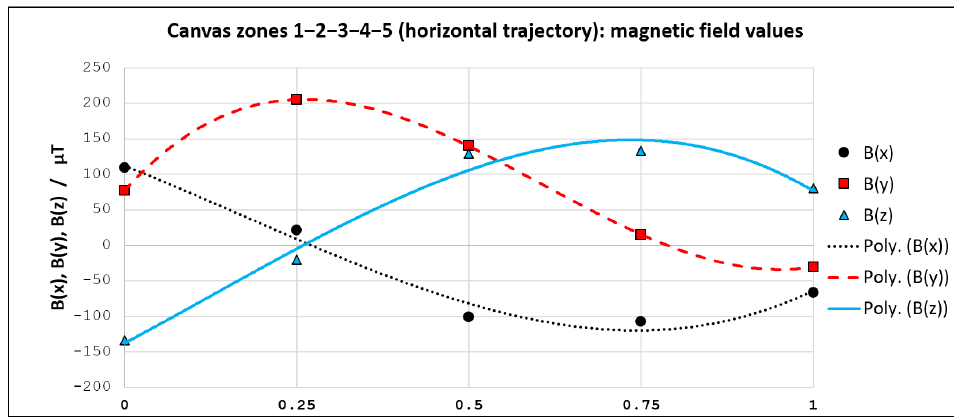
Figure 15. Curve fitting models for the selected horizontal trajectory.